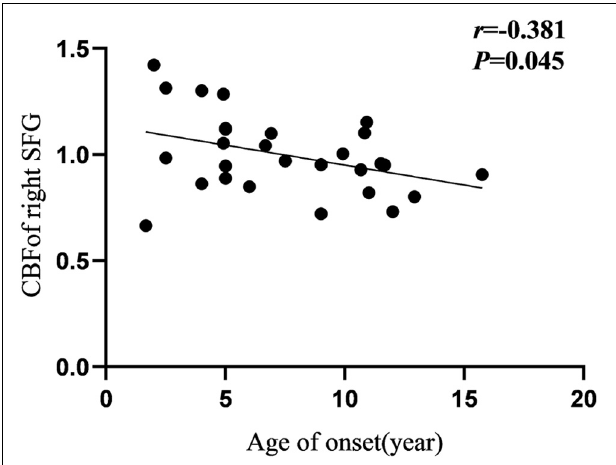
FIGURE 5 | Pearson correlation between CBF of right SFG and age of onset in IGE patients. CBF, cerebral blood flow; SFG, superior frontal gyrus.